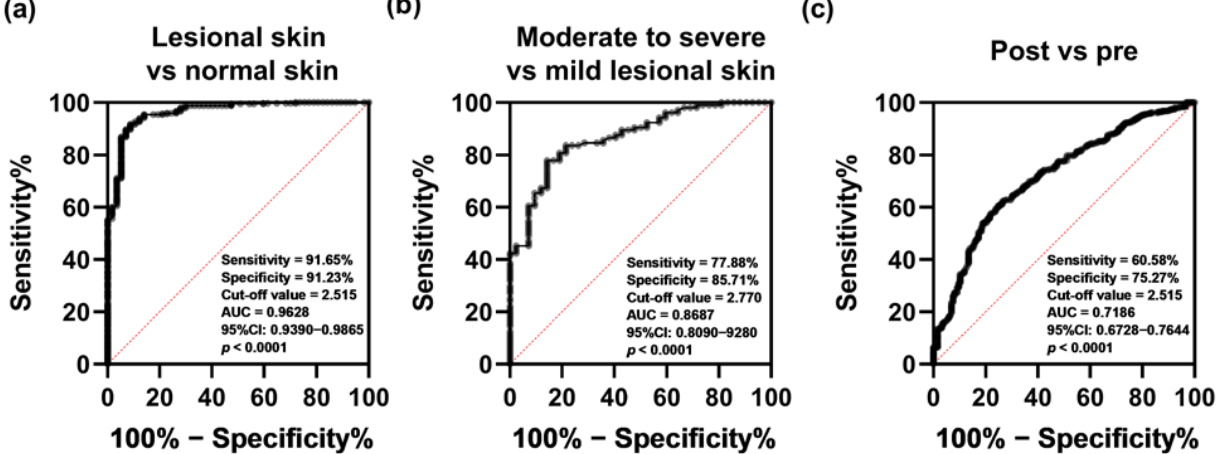
Figure 2. Diagnostic value of BTC in AD. The expression level of BTC in AD can be used to distinguish skin lesions from normal skin ( a ), moderate to severe skin lesions from mild skin lesions ( b ), and pretreatment lesions from posttreatment lesions ( c ).